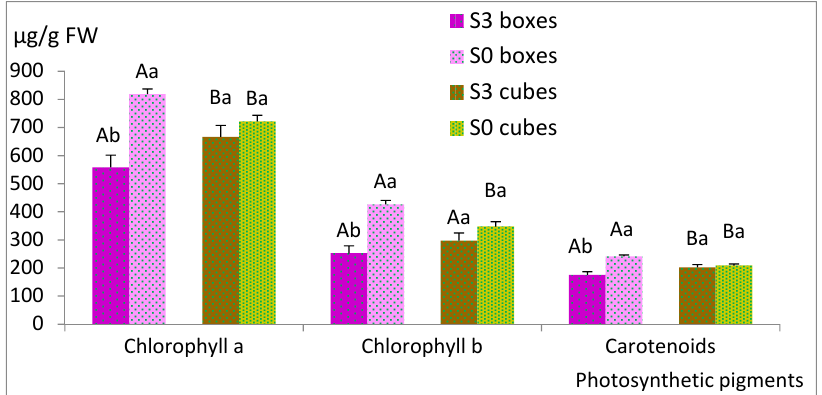
Figure 4. Effect of support material (rockwool and plastic boxes) and sucrose supplementation (S0 and S3, corresponding to 0 and 3% sucrose, respectively) on pigment content of willow shoots grown in continuous immersion bioreactors. Shoots were grown in MS medium with half-strength nitrates and 0.22 µM BA for 8 weeks. Values are presented as mean ± standard error of 12 explants. For each variable, different uppercase letters indicate significant differences in relation to the support, and different lowercase letters indicate significant differences relative to the sucrose supplementation ( p < 0.05). Due to the significant interaction found in for all parameters, Bonferroni’s adjustment was applied to detect simple main effects.